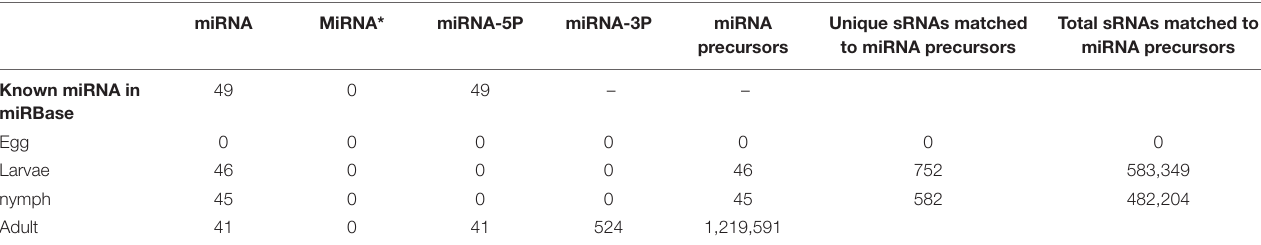
FIGURE 3 | Comparison of differential expression levels of known microRNAs in different developmental stages. Each point in the figure represents a microRNA. The X -axis and Y -axis show the expression levels of microRNAs in the two samples. The red points represent microRNAs with ratios > 2; the blue points represent microRNAs with 1/2 < ratios ≤ 2; the green points represent microRNAs with ratios ≤ 1/2. Ratios = Normalized expression in the treatment/Normalized expression in the control. Panel (A) represents different expression between nymphs and adults; (B) represents different expression between larvae and adults; (C) represents different expression between larvae and eggs; (D) represents different expression between nymphs and eggs; (E) represents different expression between nymphs and larvae. TABLE 2 | Known miRNA alignment and expression